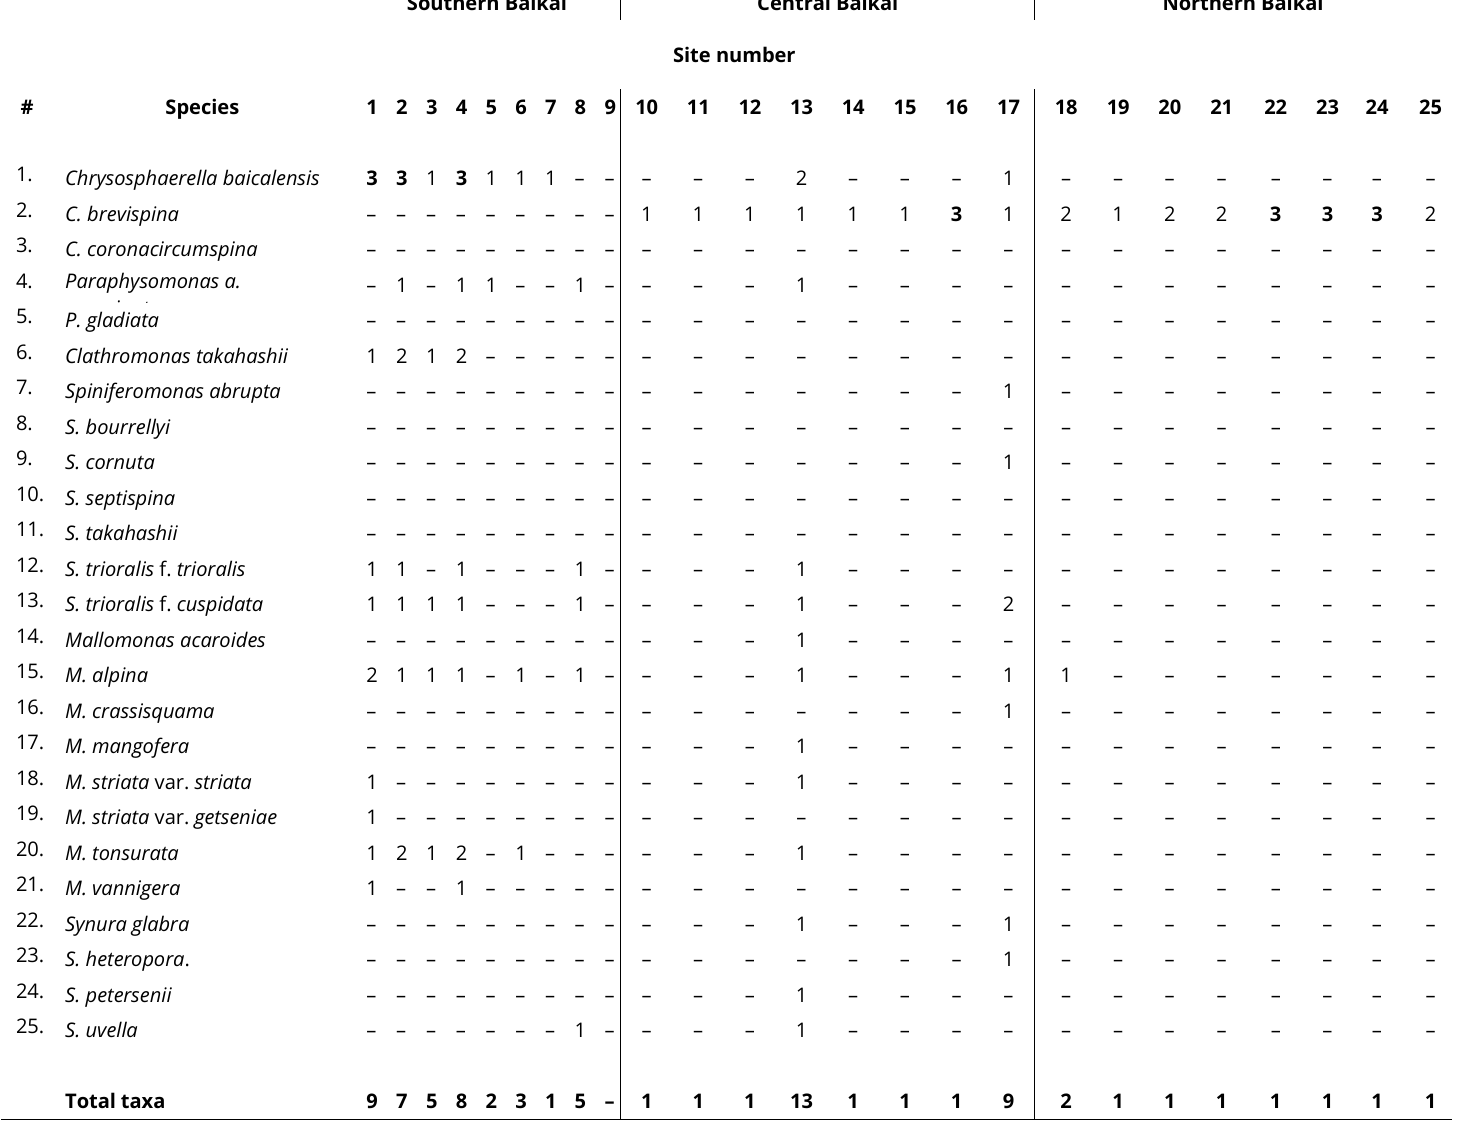
Table 2. List of species and intra-specific taxa of silica-scaled chrysophytes in Lake Baikal observed in May-June. Site numbers correspond to sites in Fig. 1. Abundance was estimated according to the following scale: